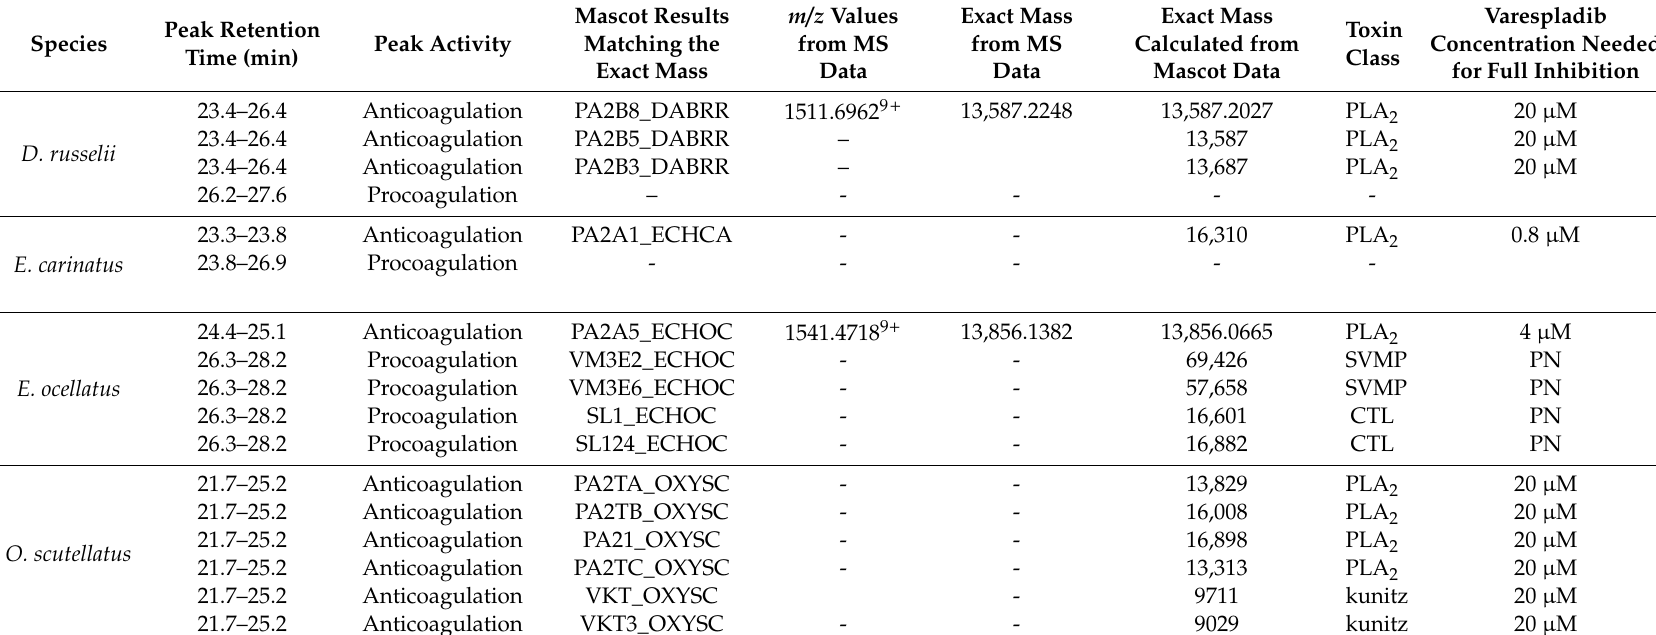
Table 2. Part 2 —(continuation of table from previous page). Correlated LC-MS masses and proteomics data for coagulopathic venom toxins activities (peak retention times are adapted from Figure 4; SVMP: Snake Venom Metalloproteinase; SVSP: Snake Venom Serine Protease; CTL: C-Type Lectin; kunitz: kunitz-type serine protease inhibitor; PN: Partly Neutralized at 20 µ M varespladib; NOI: No Observed